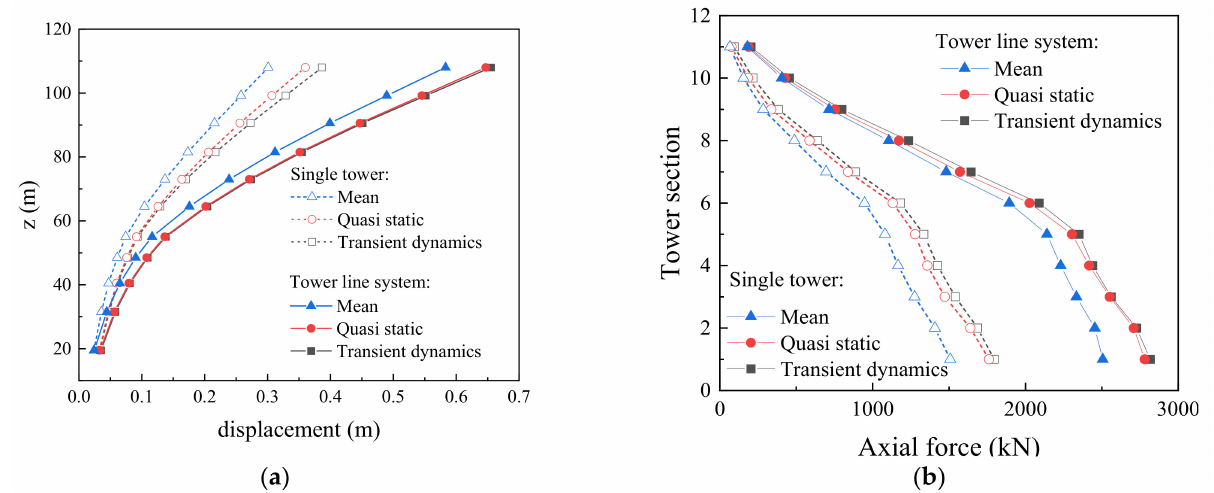
Figure 12. Distribution of displacement and axial force along the tower height: ( a ) displacement; ( b ) axial